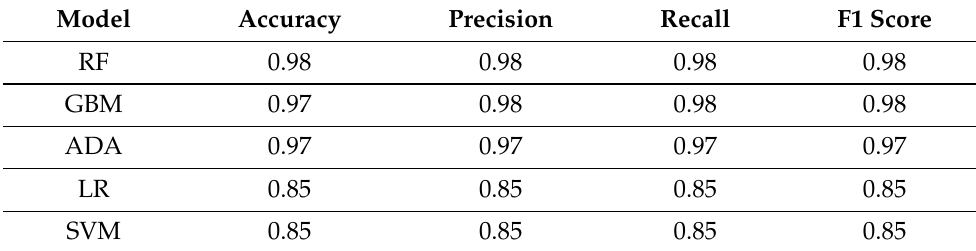
Table 9. Results of machine learning models using original feature